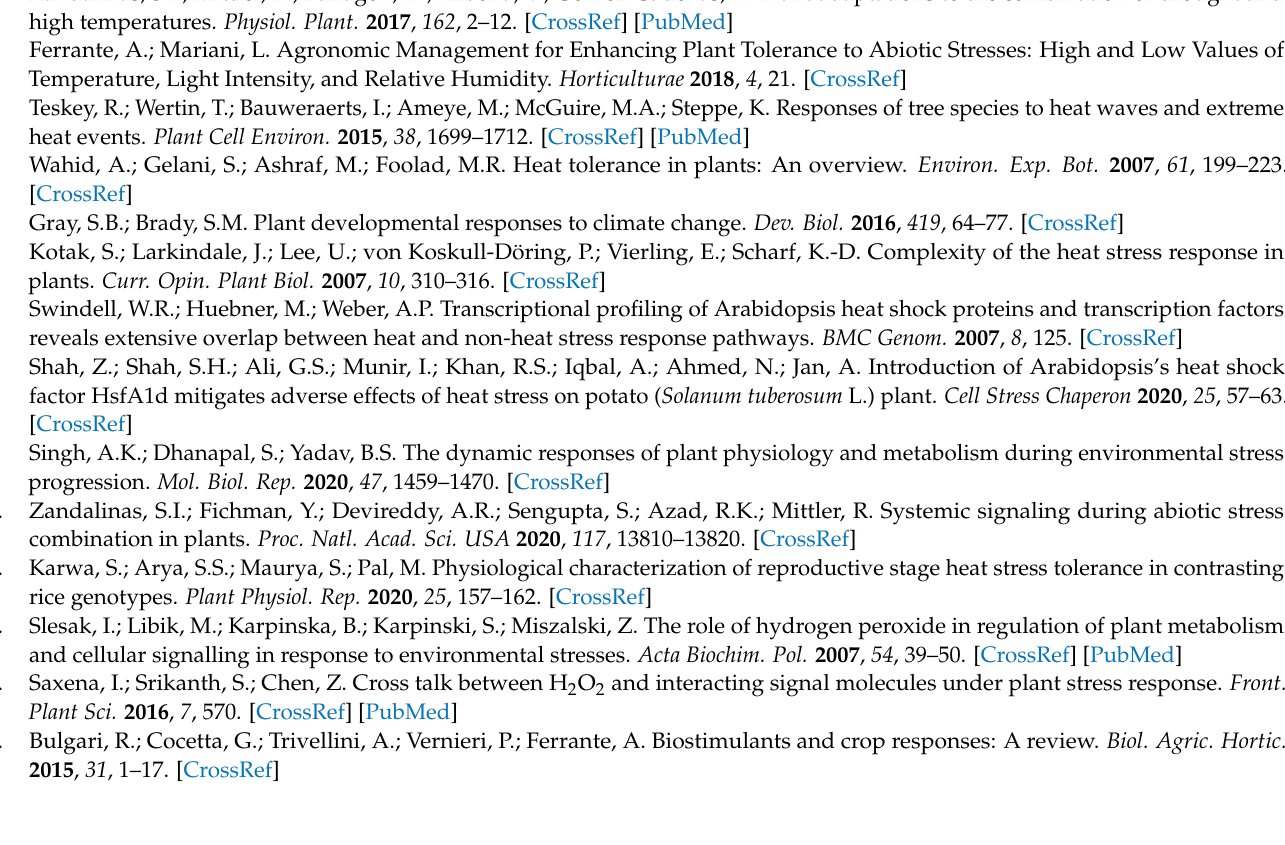
Table S2: Terms and categories used in the DAVID analysis. Supplementary Dataset S1; Supplemen- tary Dataset S2; Supplementary Dataset